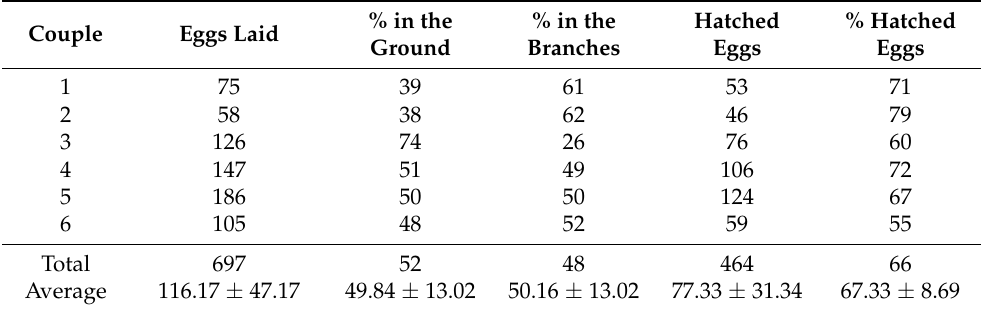
Table 2. Number of eggs laid by Aclees taiwanensis couples under laboratory conditions (25 ± 2 °C and 65% relative humidity (RH)) both in the soil and in the bark of Ficus carica branches. % in Couple Eggs Laid